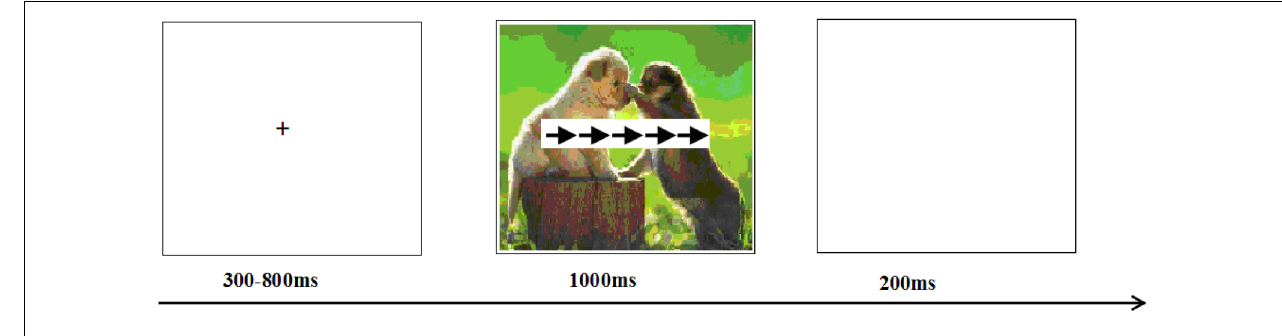
FIGURE 1 | The diagram of our experimental task.